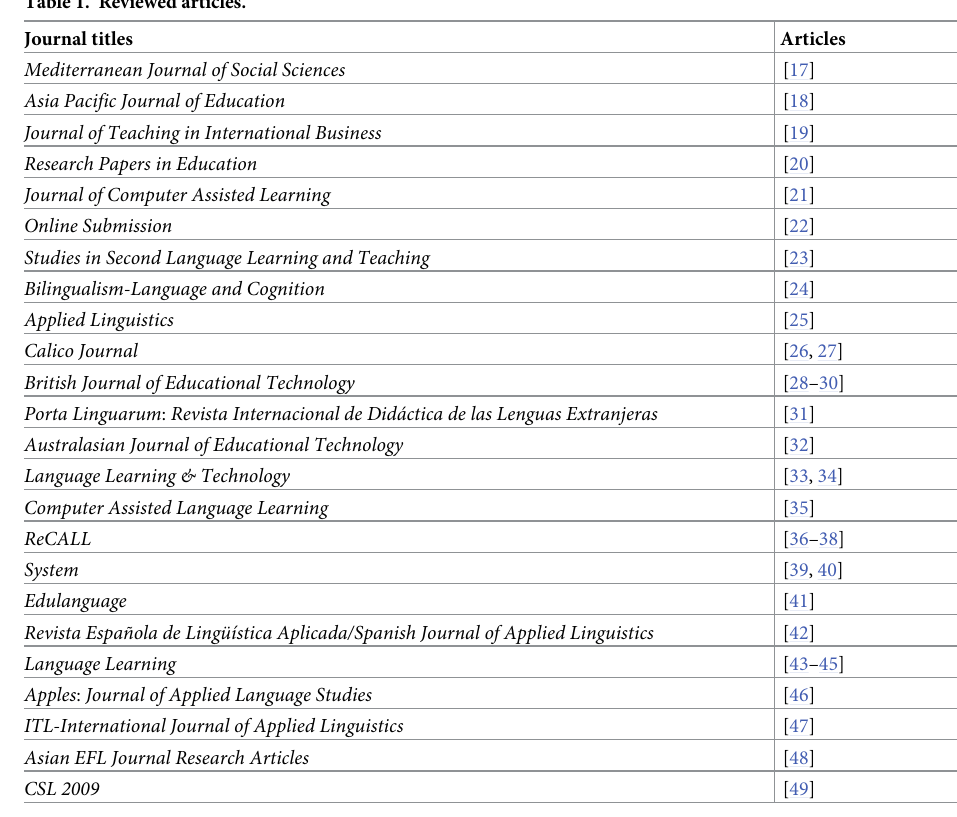
Table 1. Reviewed